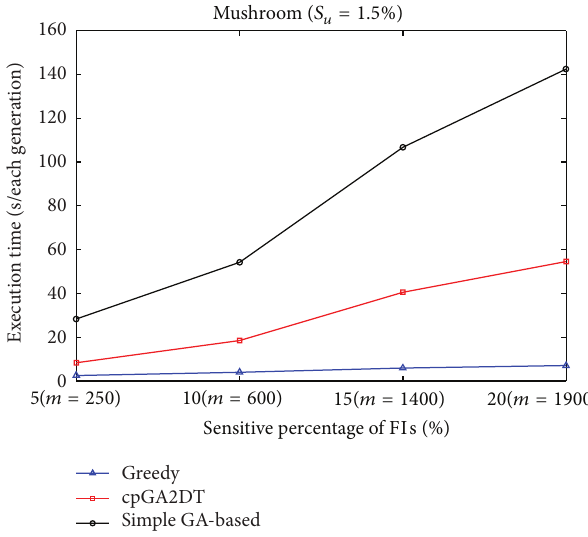
Figure 7: Comparisons of execution time at various sensitivity percentages for mushroom database.